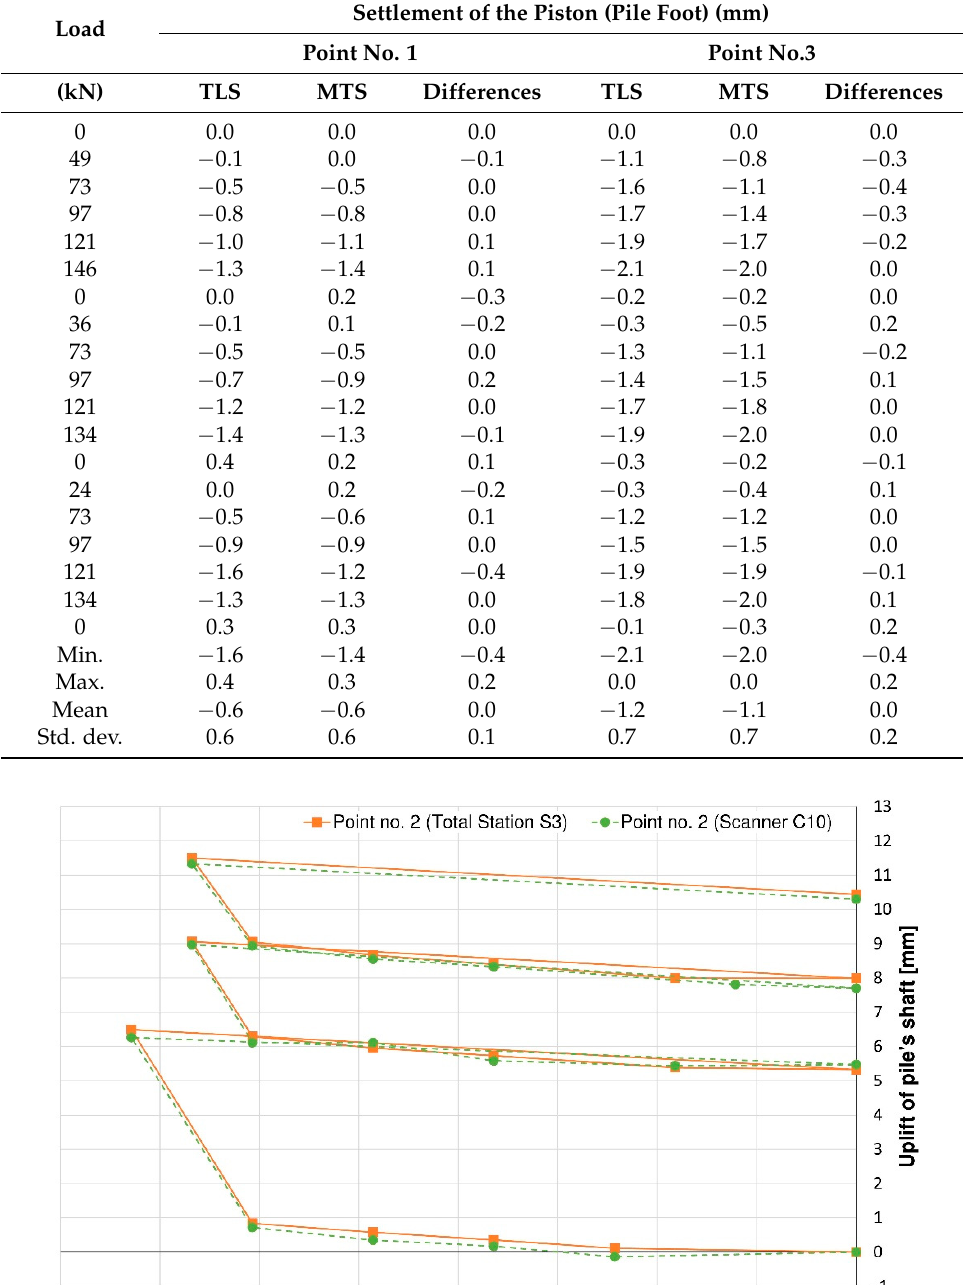
Table 5. The settlements of the piston (pile foot) for checkpoints no. 1 and no. 3 calculated from MTS and TLS.